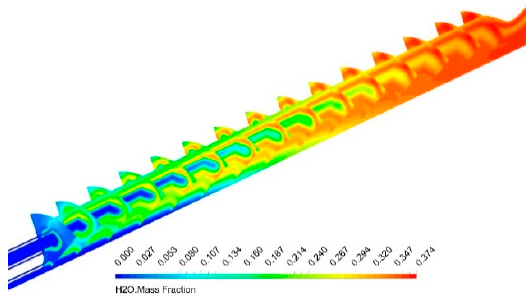
Figure 16. The H 2 O mass fraction field (50% axial scaling).